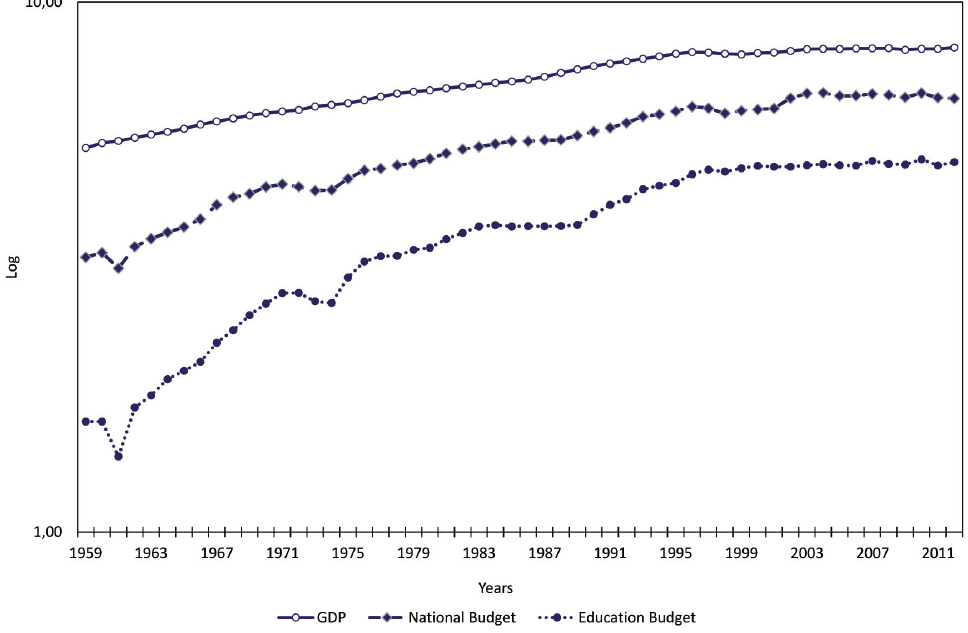
Figure 3: Increase of GDP, national budget and education budget in real terms – Log* * Note: Semi-logarithmic landmark can be used to evaluate the growth rate of a variable which evolves over time. Whatever the level of the variable, identical growth rates will be represented by segments having the same slope. Growth rates can thus be compared disregarding scale